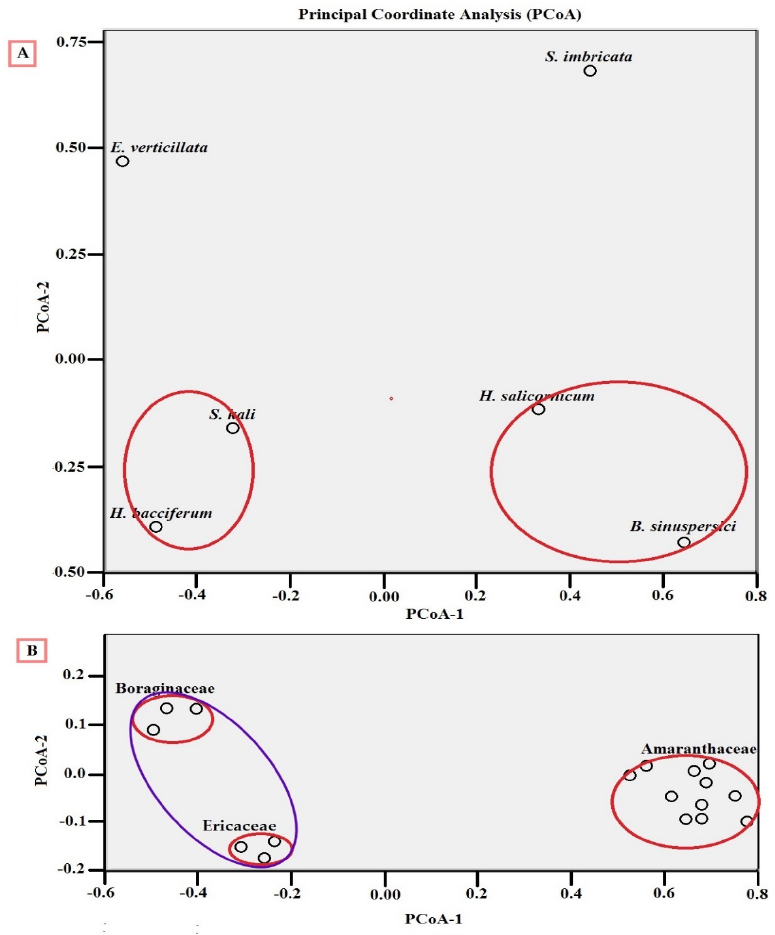
Figure 5. Multidimensional scaling using principal coordinate analysis (PCoA) plots of the com- munity structure of EF in relation to: ( A ) the plant host and ( B ) the family of the plant host. The analyses were conducted based on a distance-dissimilarity matrix using Euclidean distance to have a plot in the common two-dimensional space showing the ordination of plant species and plant family data sets of EF community structure. Red and purple circles show the close coordination of EF communities of the same plant host and plant